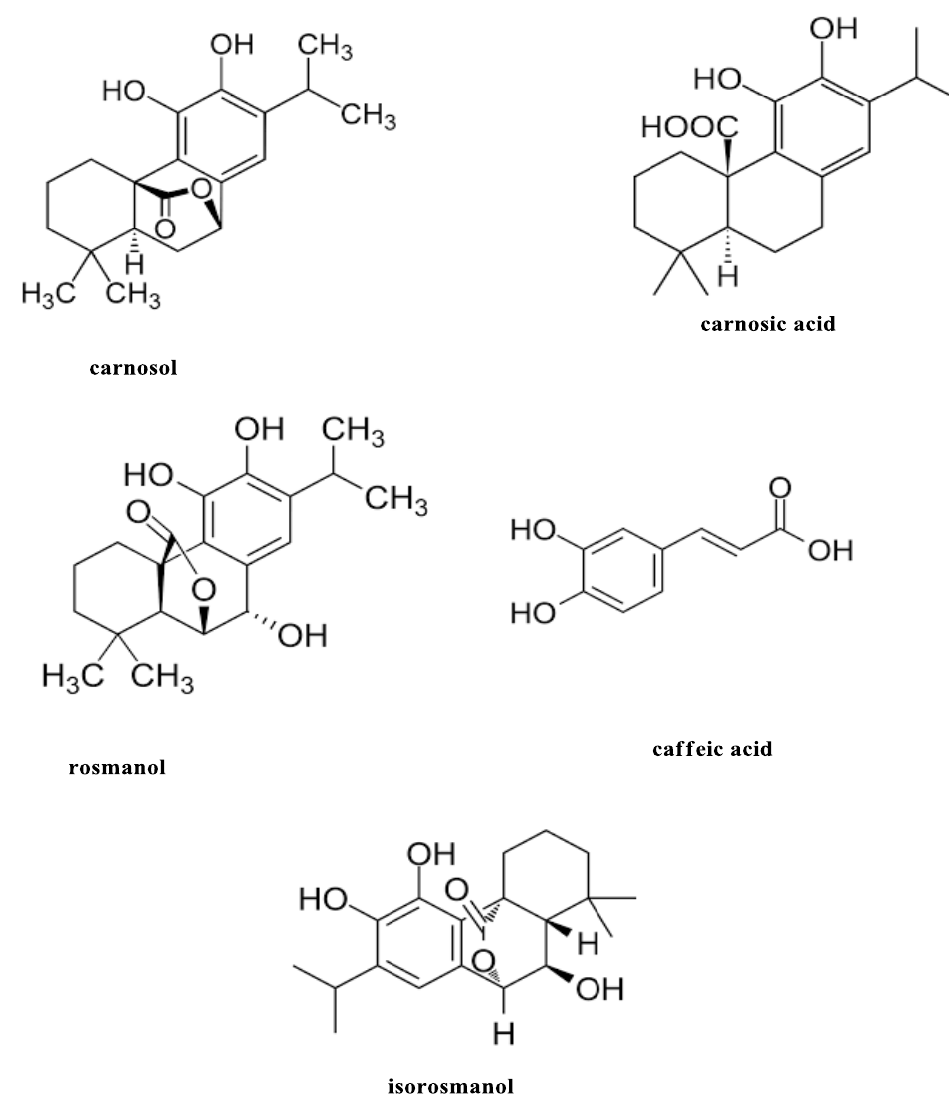
Figure 1. Chemical structure of biologically active phytochemicals in rosemary leaves. Using rosemary leaf extract as a capping and reducing agent, Co 3 O 4 NPs were syn- thesized using a completely green approach wherein no organic or inorganic